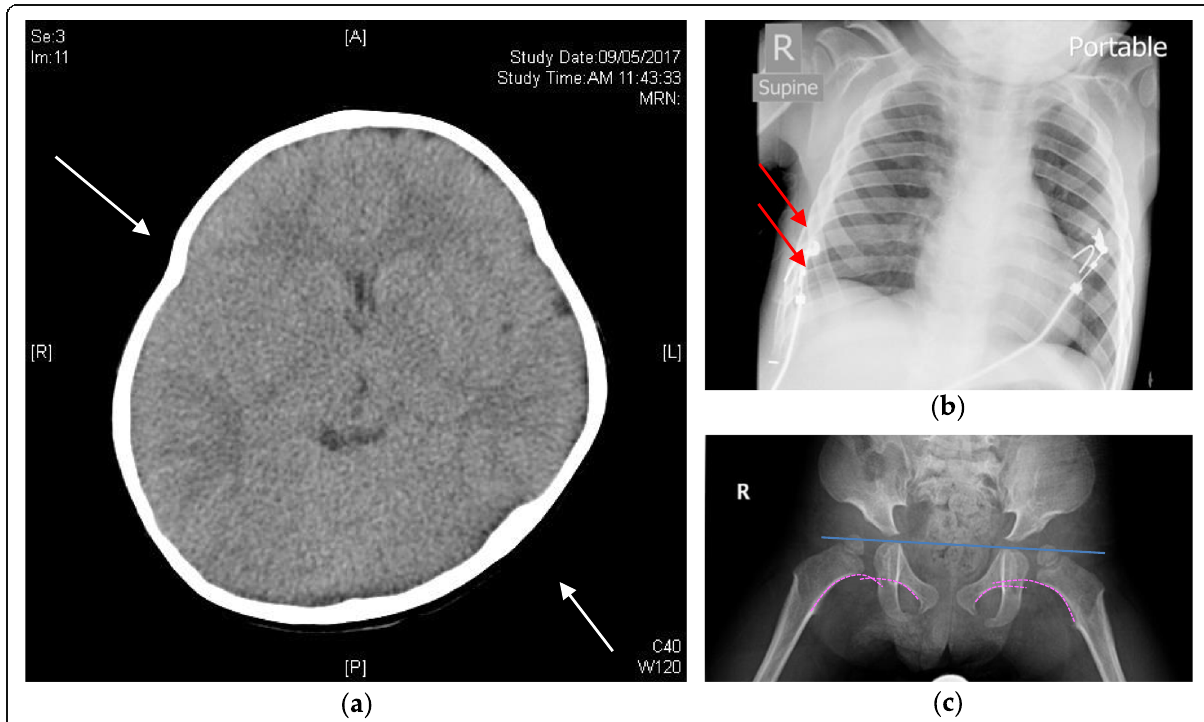
Fig. 2 Imaging investigations of skeletal deformities. a Non-contrast computed tomography scan of the brain at 21 months, showing the deformed skull shape (white arrows). The scan also revealed other abnormalities as described in-text. b Subtle widening of the ribs was noted (red arrows) on retrospective review of a chest X-ray taken on an admission for viral infection at 28 months. c Hip X-ray at 30 months, showing subluxation of bilateral hip joints. The femoral heads are above the Hilgenreiner ’ s line (in blue) and bilateral Shenton lines (dashed, in pink) show